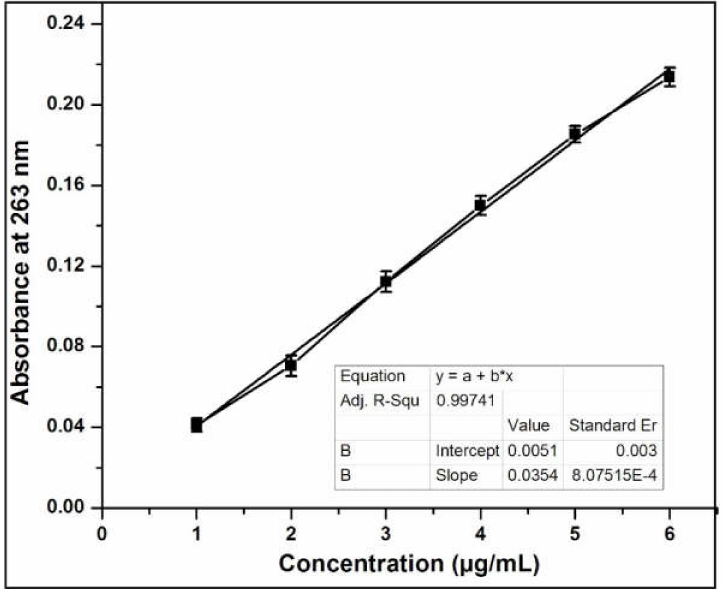
Figure 2. Calibration graph of INH at λ max 263 nm.